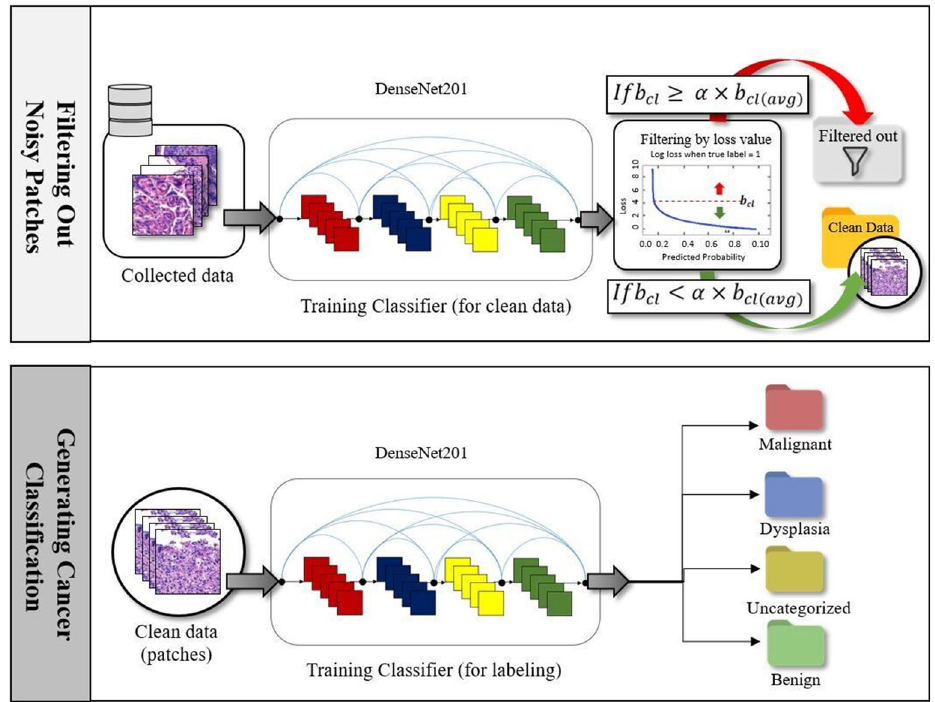
Figure 6. The second and third phases of the proposed LossDiff method.